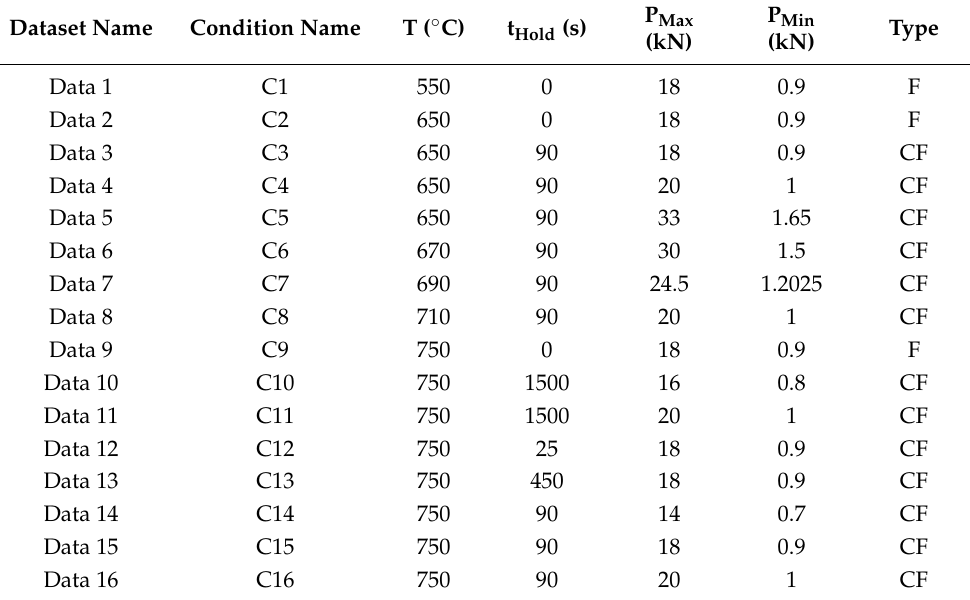
Table 2. Groups of CG data under various loading conditions at elevated temperatures.